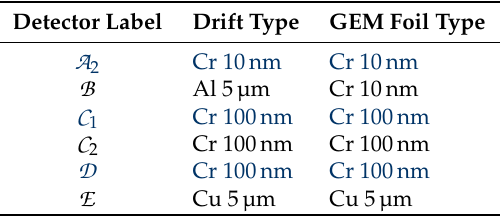
Table 1. List of assembled and tested